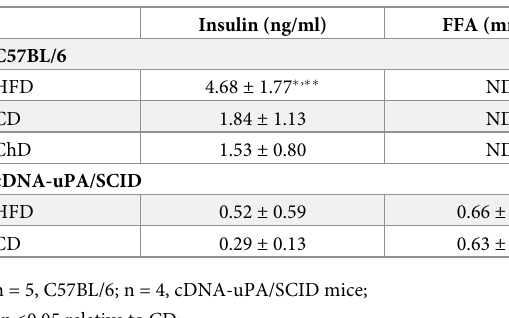
Liver sections stained with hematoxylin-eosin and Oil-Red-O showed no lipid accumula- tion in mice receiving the CD or ChD diets, and had undistinguishable pathology profiles. In contrast, mice that received the HFD demonstrated macrovesicular steatosis in 80–90% of hepatocytes, as anticipated (Fig 2). Overall, our data showed that the chow diet and the purified ingredient control diet sup- ported body weight to a similar extent in mice, despite a slightly higher calorie intake in chow- fed mice. Glucose levels under fed conditions were higher in the last group. The fact that we observed differences between the two control diet groups indicates that the purified ingredient diet is more appropriate as control diet than chow.